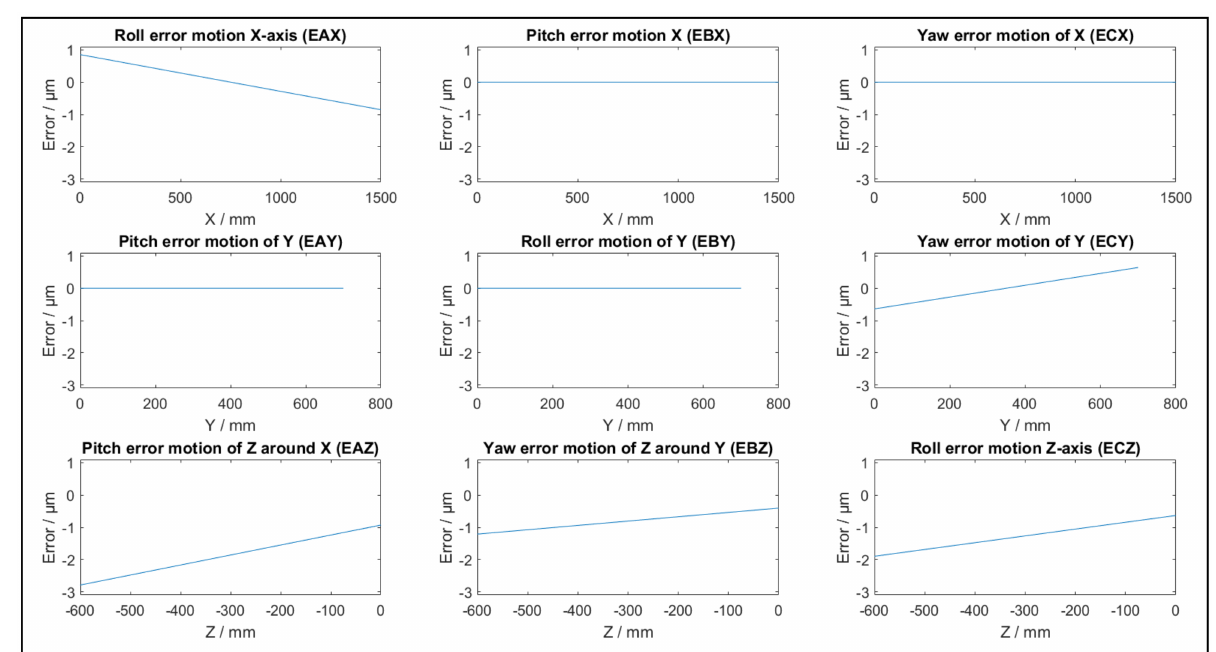
Figure 3. Example of angular errors of a single simulation of a virtual CMM.